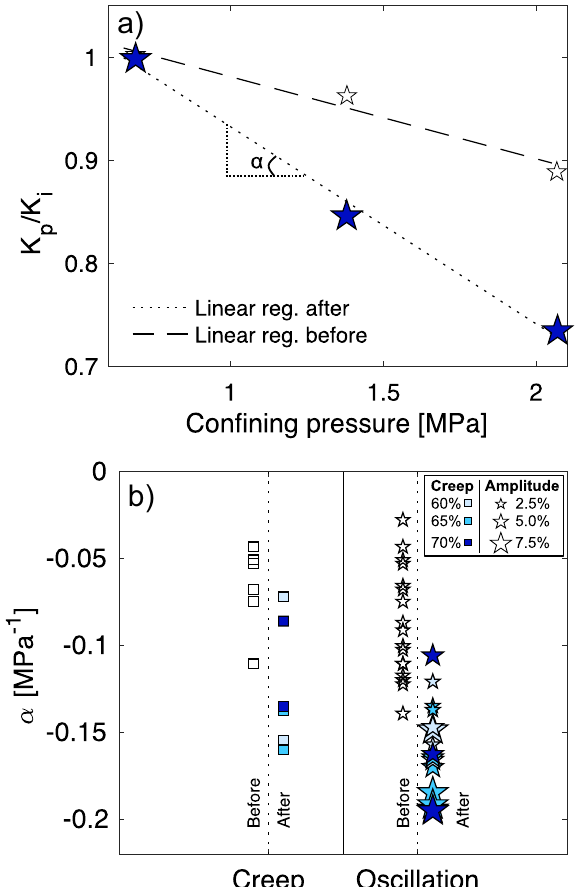
Figure 7. Pressure dependence of permeability in pre- and post-test samples. ( a ) Normalised permeability (K p is the permeability at a given confining pressure, K i is the permeability at the lowest confining pressure, 0.7 MPa) as a function of confining pressure for a sample pre-test (hollow stars) and post-test (blue stars). The dashed and dotted lines represent the linear regressions calculated for pre- and post-test samples, respectively. The permeability pressure dependence, or permeability change rate, α, corresponds to the slope of the linear regression. ( b ) Permeability change rates, α, (as explained in a ) calculated before (hollow symbols) and after deformation for samples in creep (squares) and oscillation (stars) tests. For both creep and oscillation tests, the different shades of blue correspond to different stresses at each creep condition (the darker the shade, the higher the stress). For oscillation tests, the size of the star depicts the amplitude of the stress oscillation, with small stars corresponding to ± 2.5%, intermediate to ± 5%, and large to ± 7.5% of the creep stress